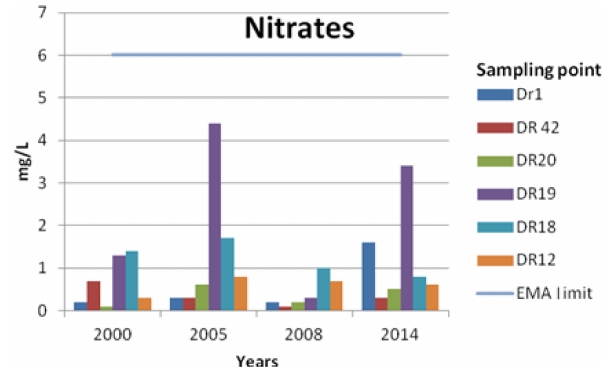
Figure 9. Nitrates variation along sampling points.